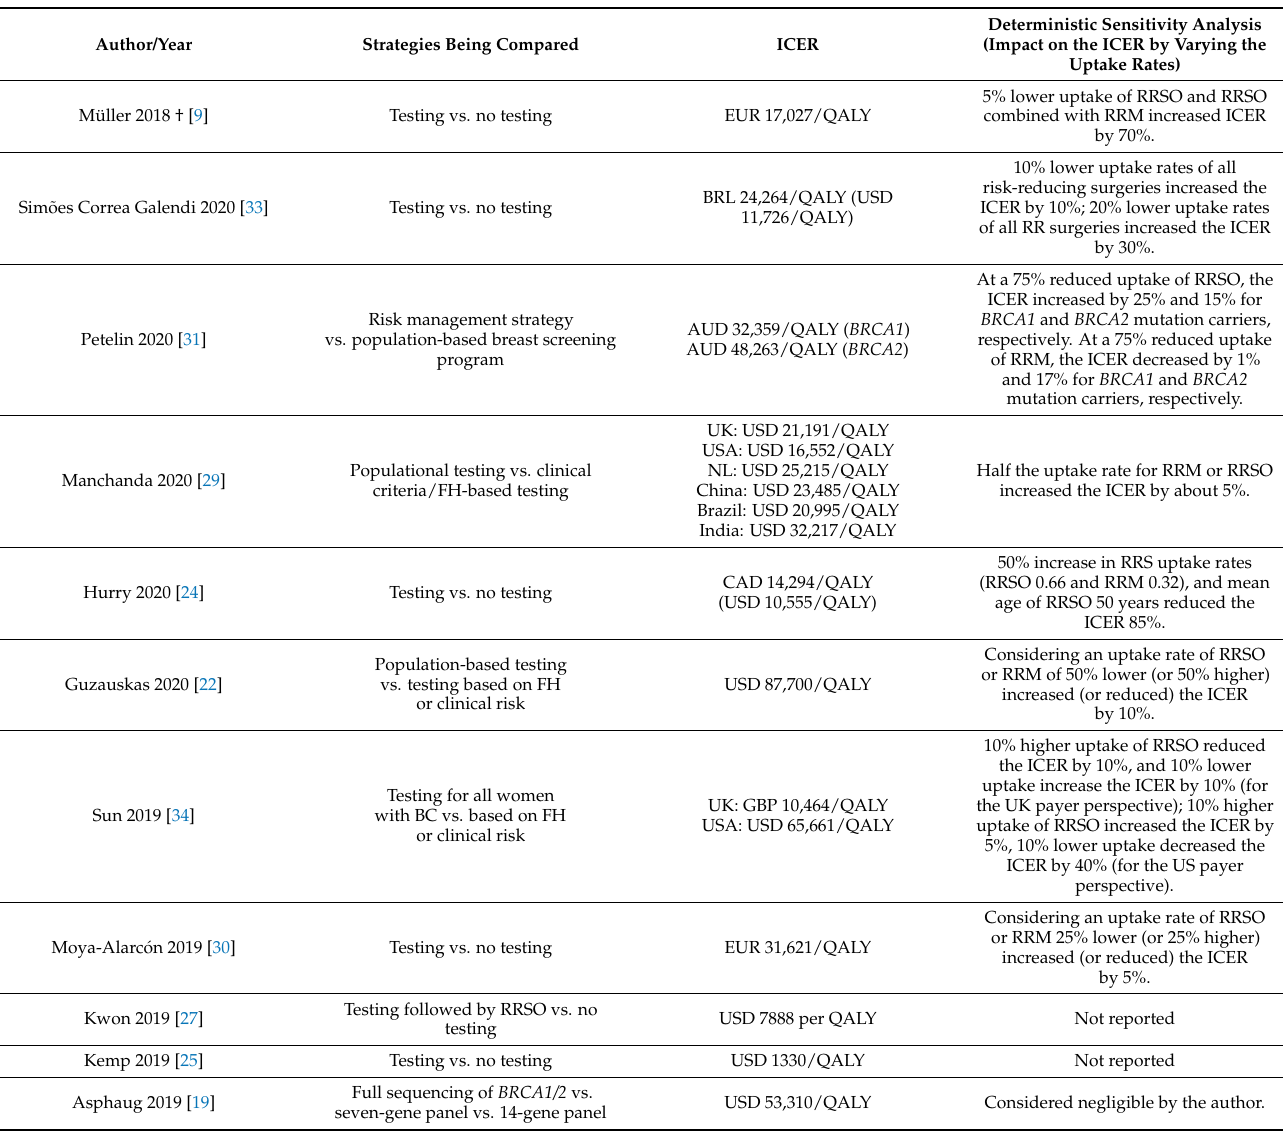
Table 3. Results of deterministic sensitivity analysis reported by the included